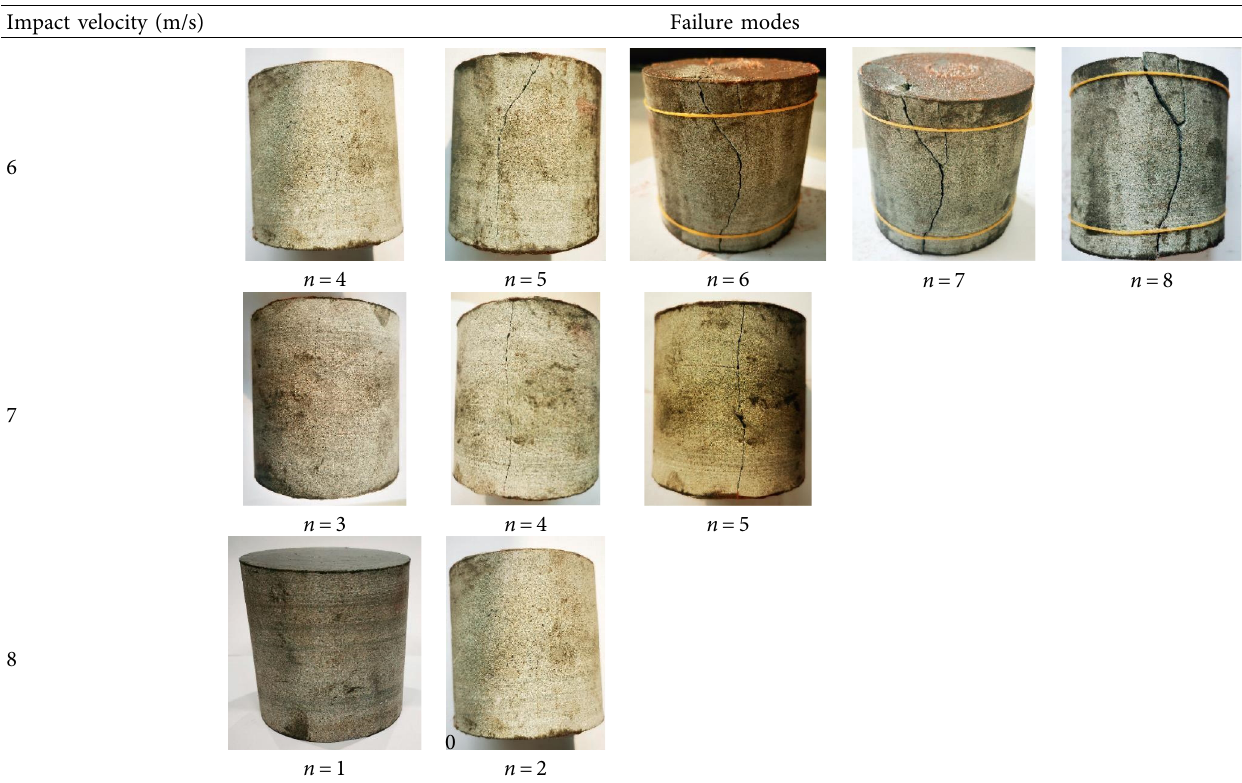
Figure 7: Peak stress with the increase of impact numbers under diferent impact velocities. Table 3: Failure modes of sandstone